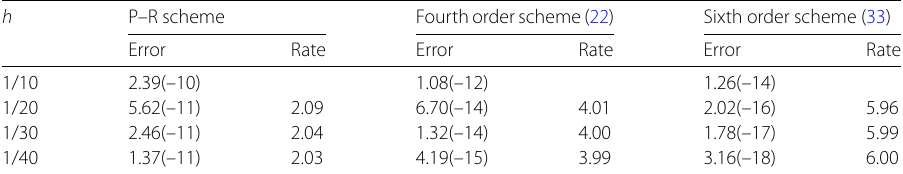
Table 3 L 2 -error and convergence rate for Problem 1 with τ = 0.001 at T =